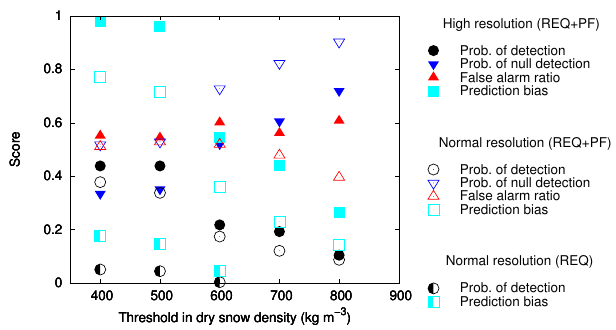
Figure 8. Contingency statistics as a function of threshold in dry snow density that defines an ice layer in the simulations, for both normal and high-resolution simulations including preferential flow (REQ+PF) and normal-resolution simulations using the Richards equation only (REQ).